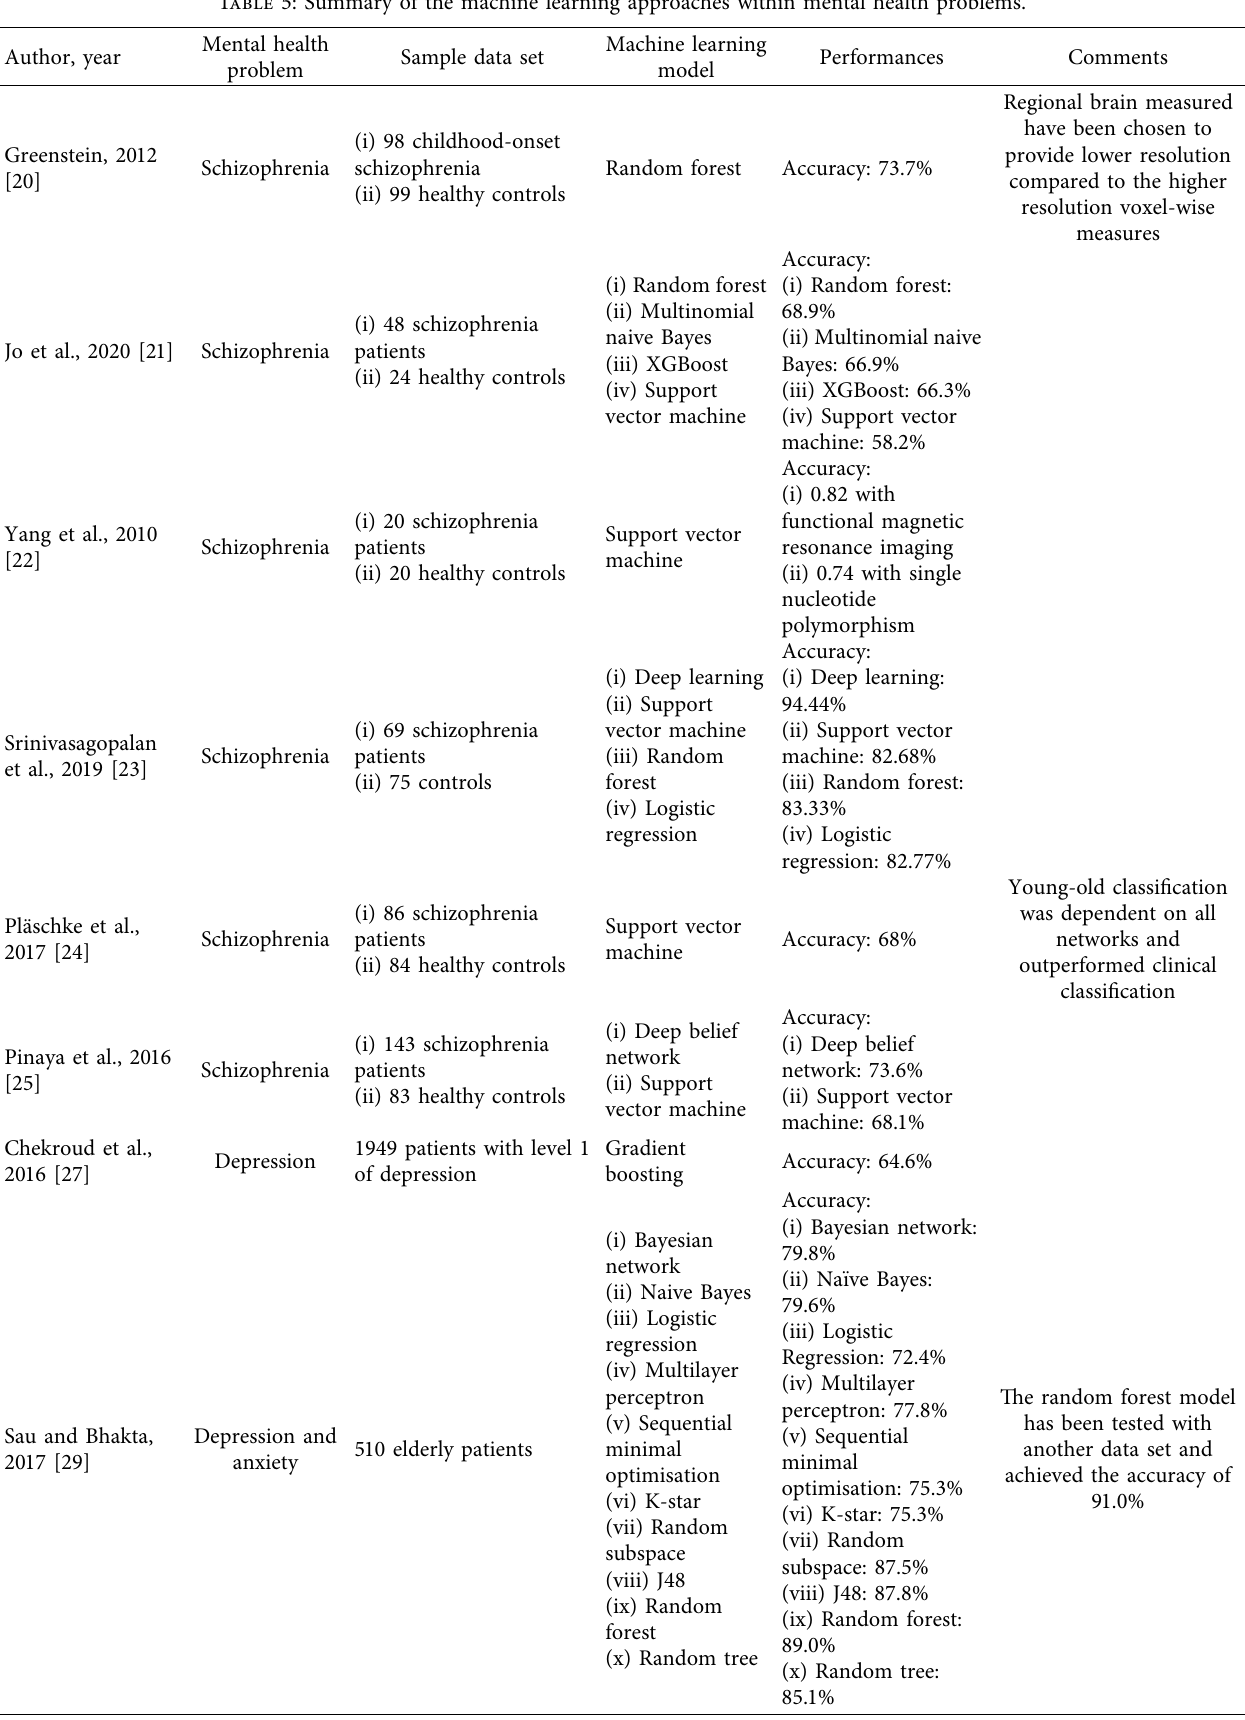
Table 5: Summary of the machine learning approaches within mental health